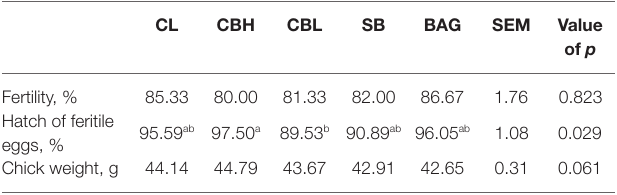
TABLE 2 | Hatching performance of yellow-feathered breeder